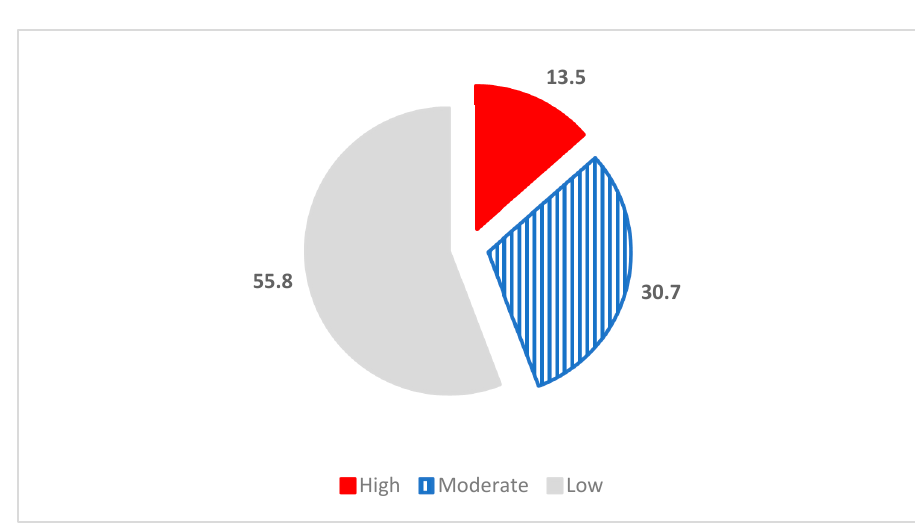
Figure 3. Level of the farmers’ recognition regarding fraudulent pesticides.